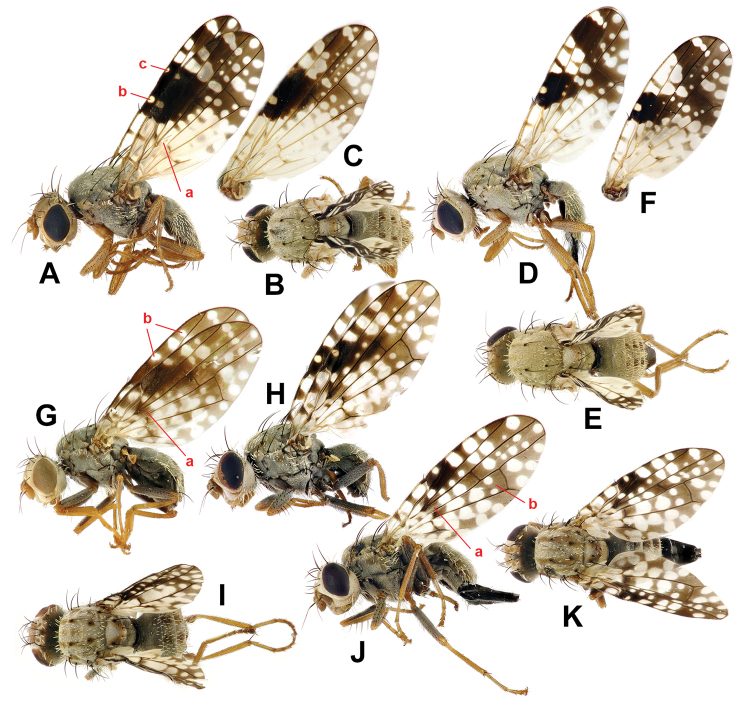
A–FCampiglossa
coeiA male, lateral view B male, dorsal view C male wing D female, lateral view E female, dorsal view F female wing G–KC.
misellaG male, lateral view H male, lateral view I male, dorsal view J female, lateral view K female, dorsal view.